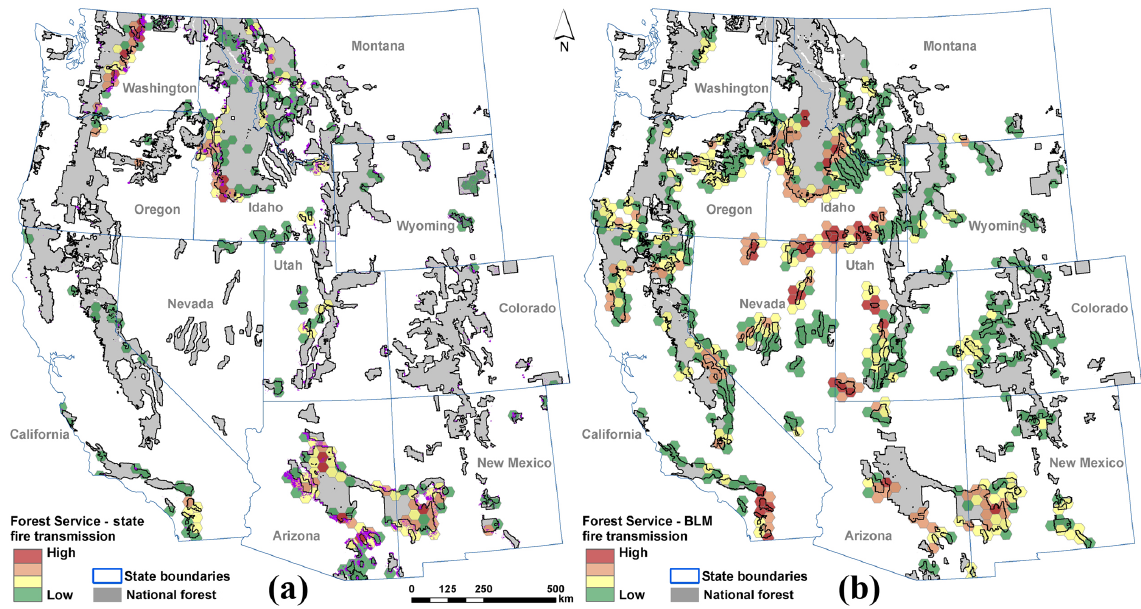
Figure A2. Cross-boundary wildfire transmission zones from Forest Service administrative lands to (a) state and (b) BLM lands. Grey areas indicate national forest lands where transmission to other land tenures is very low (high percent of self-burning